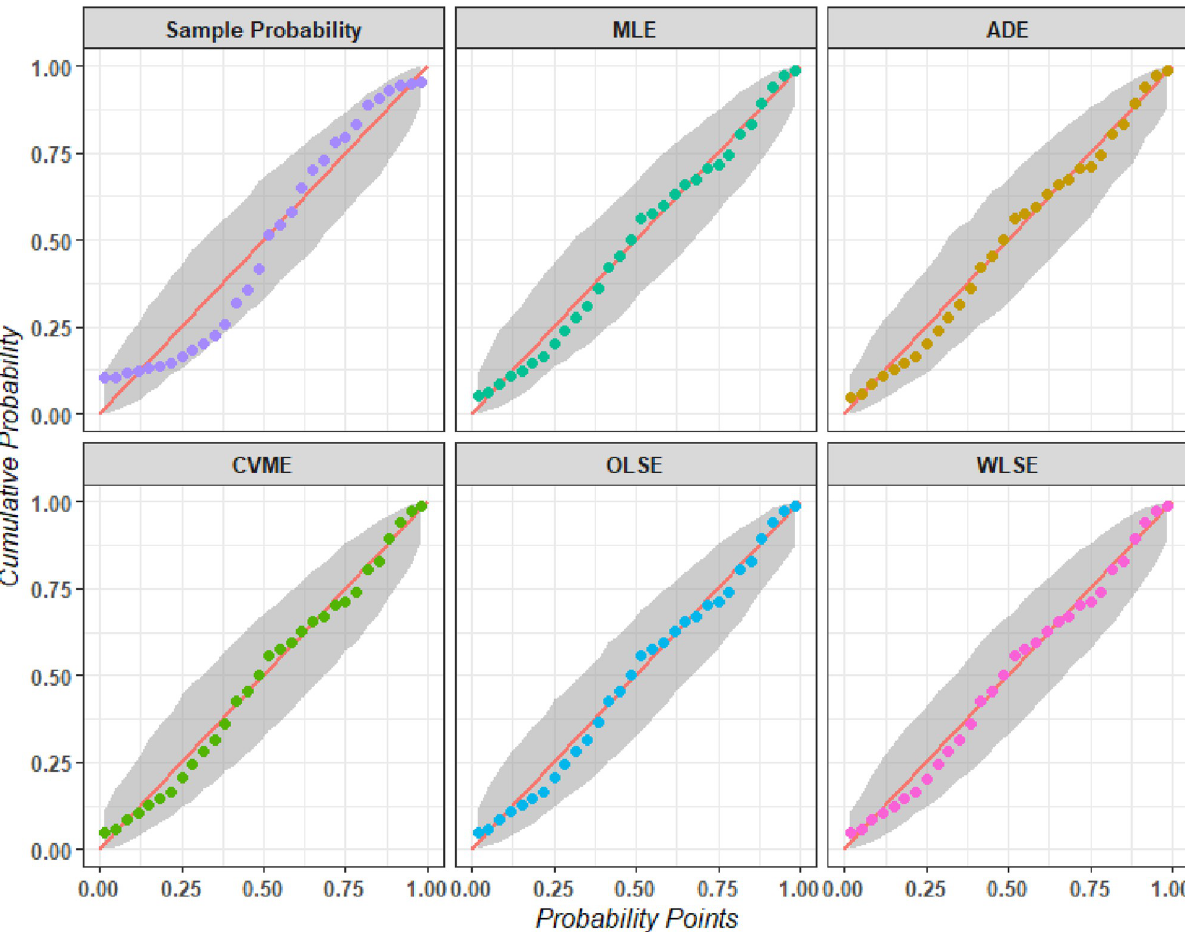
Fig 5. The PP plots for the dataset using different estimation